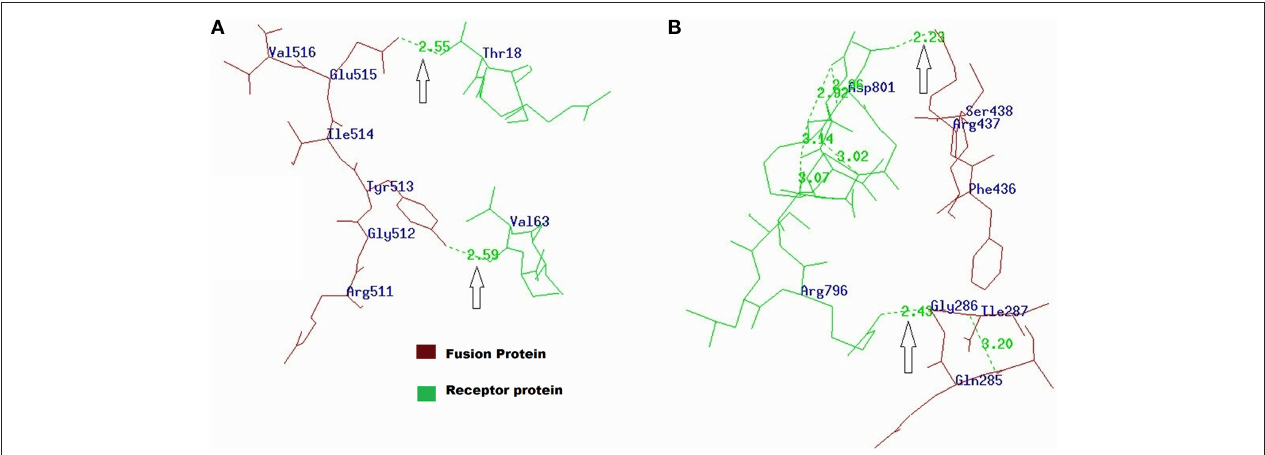
FIGURE 4 | (A) Interactions of fusion protein with Agrotis ipsilon APN receptor visualized by PDBViewer. Tyr513 and Glu515 residues of fusion protein were interacting with Val63 and Thr18 residues of Agrotis ipsilon APN receptor. (B) Interaction of fusion protein with Agrotis ipsilon cadherin receptor. The Arg437 and Gly286 residues of fusion protein were interacting with Asp801 and Arg796 residues of Agrotis ipsilon cadherin receptor.